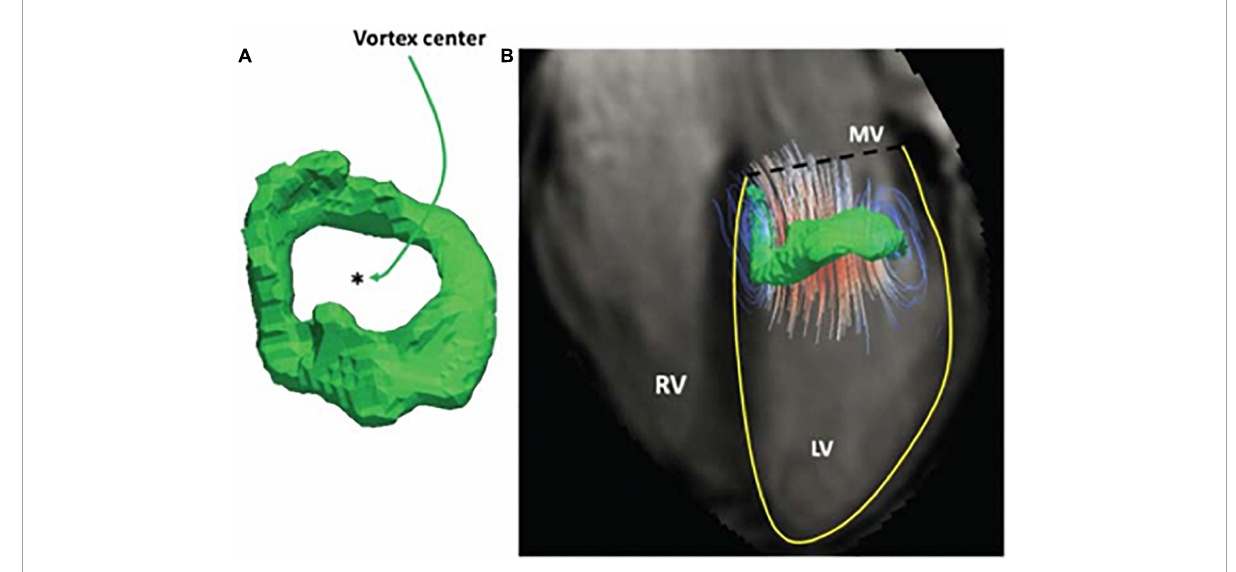
FIGURE5 Left ventricular diastolic vortex ring in a healthy volunteer. Example of early diastolic vortex ring (A) , Streamlines superimposed on a vortex in a four-chamber view (B)